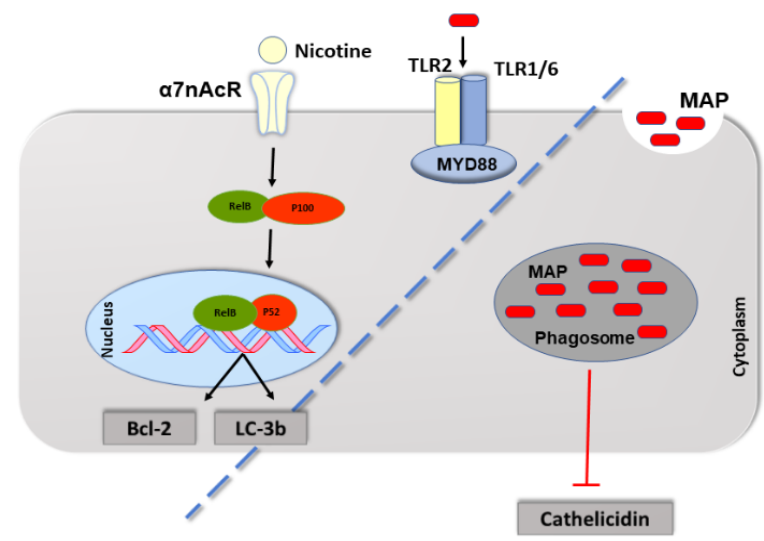
Figure 6. Schematic illustration of the role of nicotine in activation NF-kB survival pathway in MAP-infected macrophages. Nicotine through its receptor, α 7nAChR, upregulates Bcl-2 and LC-3b expressions in MAP-infected macrophages. Meanwhile MAP itself evades macrophages antimicrobial defense by inhibiting cathelicidin.